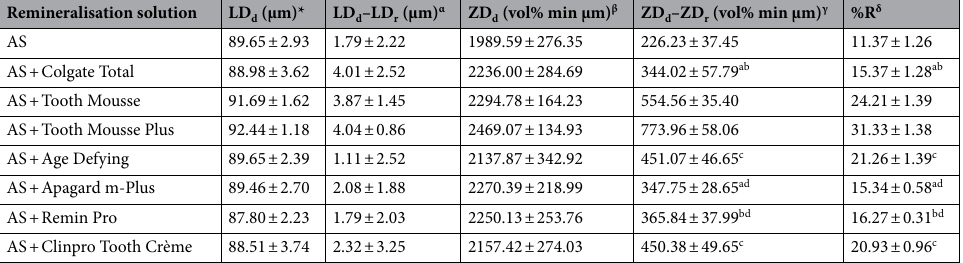
Table 4. Remineralisation of enamel subsurface lesions by treatment solutions. *LD d : ANOVA—no difference between products (p = 0.062, p > 0.05). α LD d –LD r : ANCOVA—main effects model treatment and LD d as covariate. No difference between products (p > 0.05). Effect of LD d significant (p < 0.0001). β ZD d : ANOVA—no difference between products (p > 0.05). γ ZD d –ZD r : ANCOVA—main effects treatment and ZD d as covariate. Pairwise comparisons with Sidak adjustment. Highly significant differences between products (p < 0.0001). Effect of ZD d significant (p < 0.0001). abcd same superscripts in column denote means that are not significantly different (p > 0.05). Differences between all other means highly significant (p < 0.0001). δ %R: ANCOVA—main effects model untransformed values with treatment and ZD d as covariate. Differences across treatment highly significant (p < 0.0001) and effect of ZD d also significant (p = 0.02). abcd Same superscripts in column denote means that are not significantly different (p > 0.05). Differences between all other means highly significant (p < 0.0001). All differences between treatments were measured using pairwise comparisons with a Sidak adjustment.